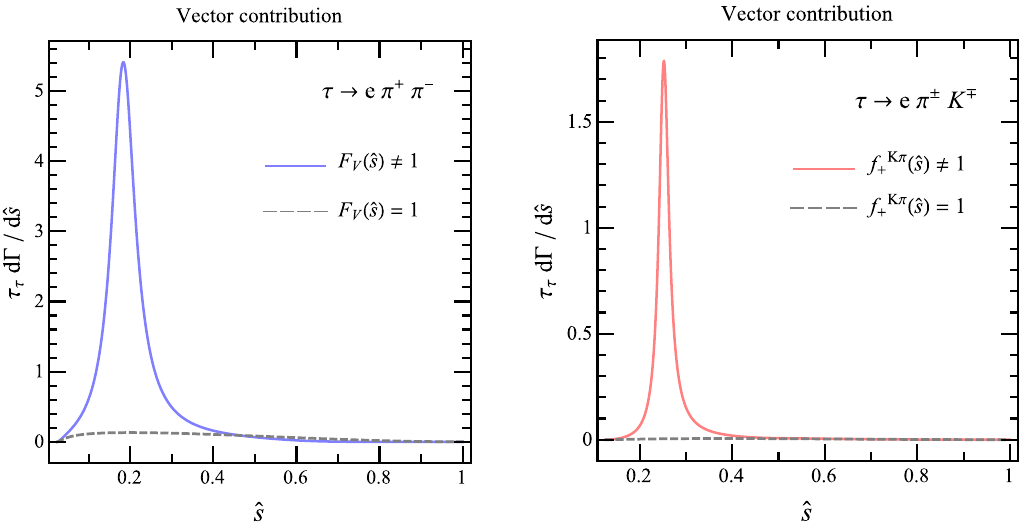
Figure 11 . Vector contributions to the differential decay rate of τ → eπ + π − (left) and τ → eπ ± K ∓ (right). The solid lines include vector form factors as a function of ˆ s , while they are fixed at 1 in the dashed lines. The Wilson coefficients are set to unity.